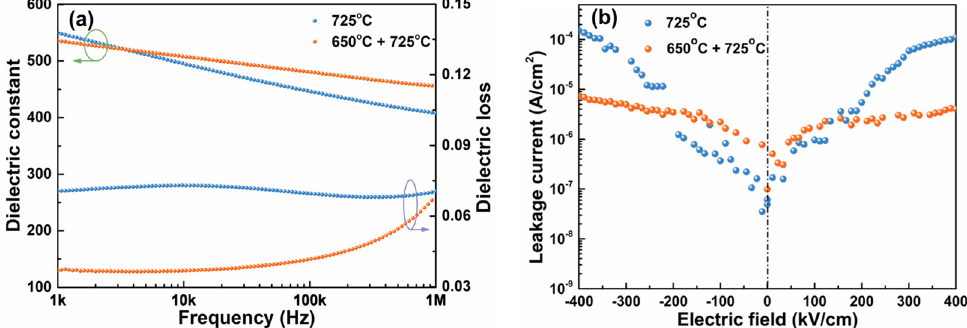
Figure 4. ( a ) Dielectric constant and loss as a function of frequency, ( b ) DC electric field dependence of the leakage current for the BNT–5.5BZ samples annealed under different conditions.